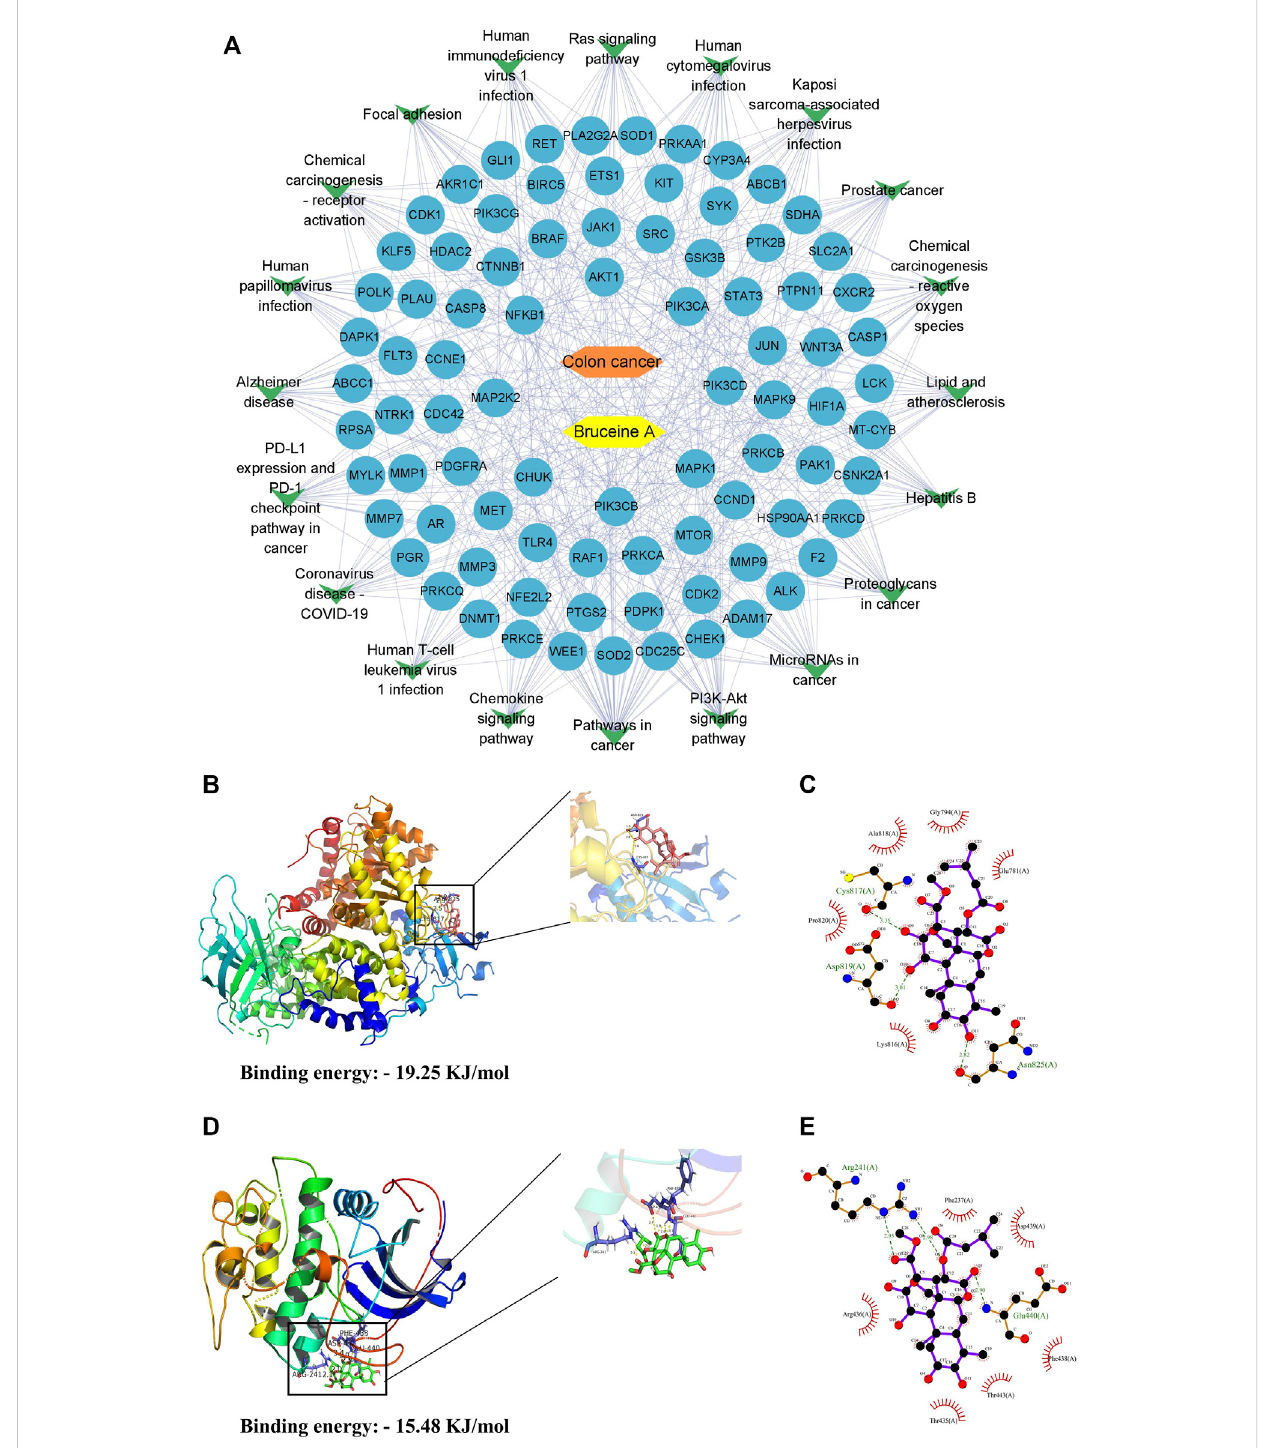
FIGURE 2 Results of molecular docking of targets with BA. (A) The compound-target-pathways network, yellow nodes indicate BA, orange nodes indicate colon cancer, blue oval nodes indicate the target nodes, and green triangle nodes indicate the corresponding pathways. (B,C) The molecular docking between BA and PI3K. 3D-diagram (B) and 2D-diagram (C) interaction analysis between BA and PI3K. (D,E) The molecular docking between BA and Akt. 3D-diagram (D) and 2D-diagram (E) interaction analysis between BA and Akt. BA molecule was displayed using a ball and stick model and the PI3K/ Akt protein was displayed using a cartoon structural